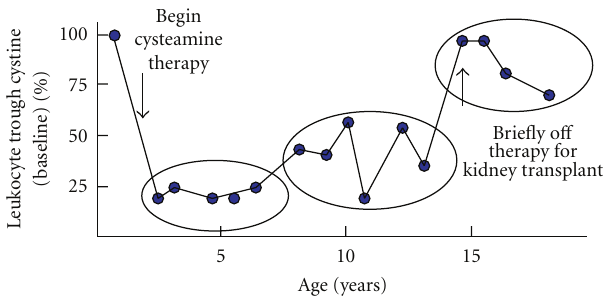
Figure 4: Leukocyte monitoring of leukocyte cystine levels in 50 Canadian children with nephropathic cystinosis. Introduction of oral cysteamine therapy (1.3g/m 2 /day in four divided doses) in early childhood achieves a rapid reduction of trough 6–8 hours after a single dose. Following a variable “honeymoon period,” mean leukocyte cystine gradually drifts upwards as compliance decreases. Cystine levels return to baseline when stopped briefly for transplant or when teenagers discontinue therapy.